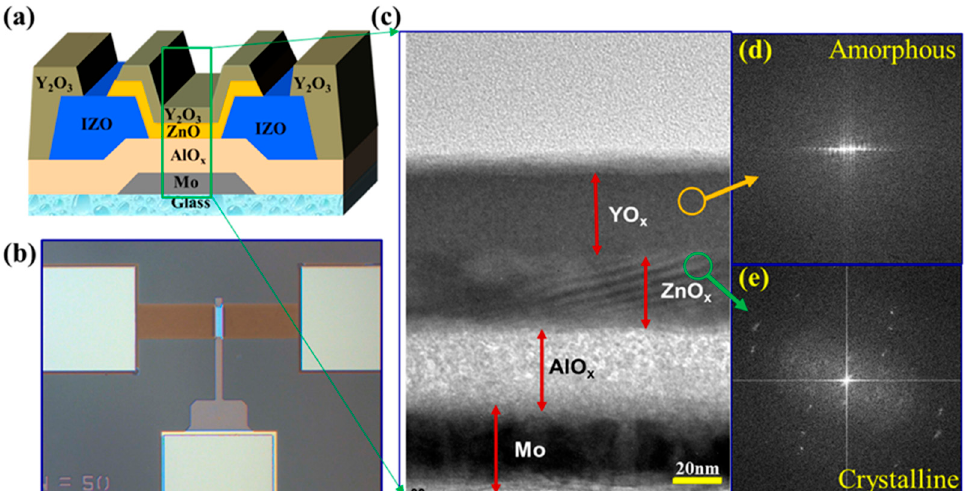
Figure 1. ( a ) Schematic diagram and ( b ) optical image of the bottom gate bottom contact ZnO TFT with Y 2 O 3 passivation by spray pyrolysis. ( c ) Cross-sectional transmission electron microscope (TEM) image of a ZnO TFT. Fast Fourier Transform (FFT) of ( d ) yellow circled area confirms the amorphous nature of Y 2 O 3 layer deposited at 400 °C and ( e ) green circled area confirms the hexagonal structured ZnO deposited at 350 °C by spray pyrolysis.